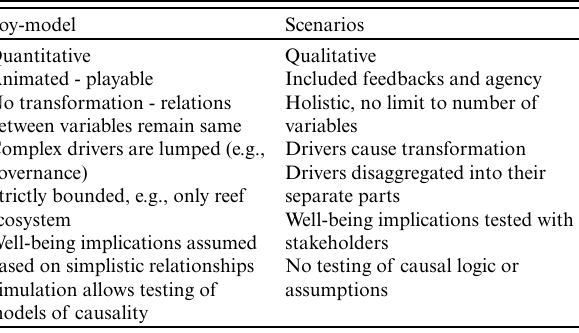
Table 2 . Comparison of the toy-model and scenarios